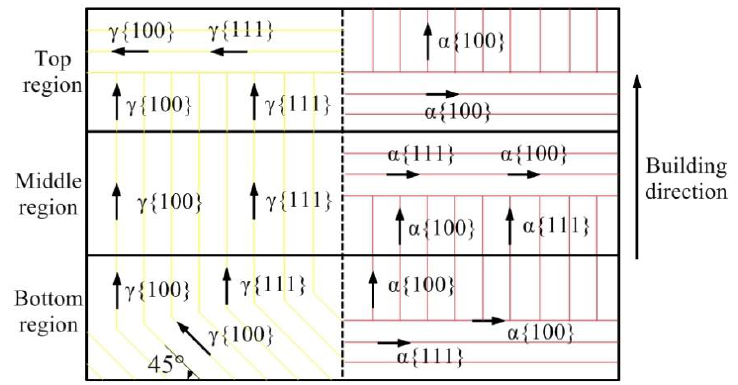
Figure 6. Grain orientation model for CMT-WAAM additive part in different zones.